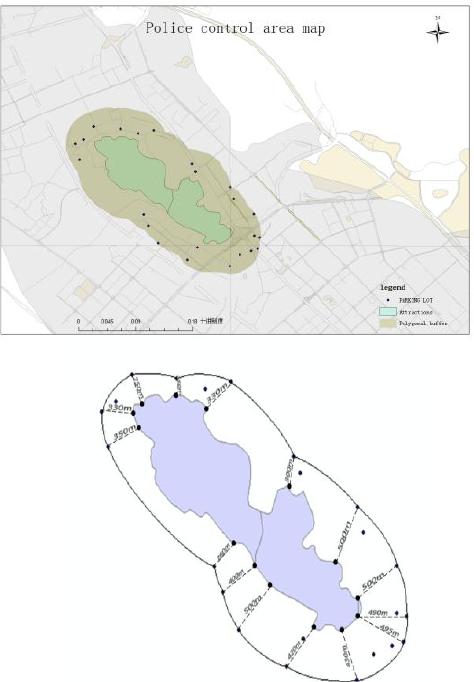
Figure 7. Polygonal buffer comparison chart (a. Traditional buffer; b.Irregular